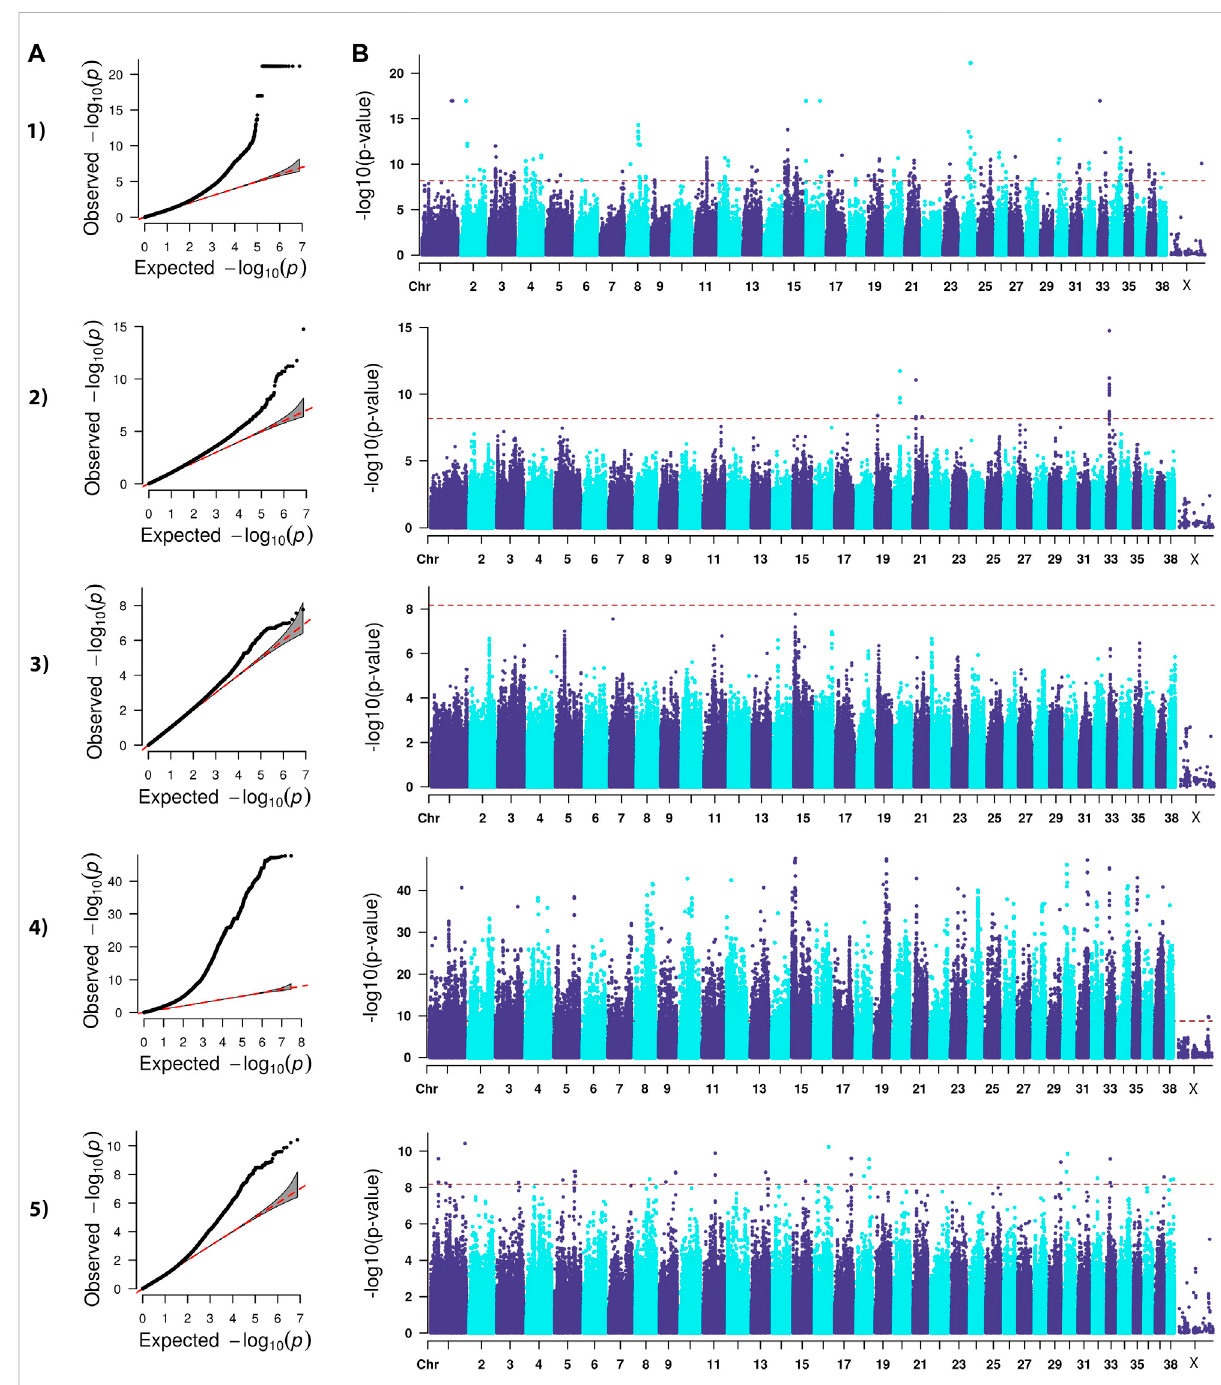
FIGURE 2 QQ (A) and Manhattan (B) plots. Comparison of four models for performing across-breed genome-wide association study using breed phenotypes for elbow dysplasia. 1) Linear mixed model, λ = 0.99, 517 signi fi cant single-nucleotide polymorphisms (SNPs) with the strongest associations on chromosome 1, 2, 8, 15, 16, 24, 30, and 33 ( p < 6.59E-9). 2) Stringent binary case-control model, λ = 1.04, 30 signi fi cant SNPs on chromosome 19, 20, 21, 33( p < 6.68E-9). 3) Lenient binary case-control model, λ = 1.01, no signi fi cant SNPs ( p < 6.64E-9). 4) Haplotype-based model, λ = 1.84, 58,592 signi fi cant SNPs with the strongest associations on chromosomes 1, 8, 10, 12, 13, 15, 19, 21, 23, 24, 30, 31, 33, 34, 35, and 37 ( p < 1.68E-9). 5) Weighted least squares model, λ = 0.96, 90 signi fi cant SNPs on chromosomes 1, 3, 5, 8, 9, 11, 13, 15, 16, 17, 18, 29, 30, 32, 33, 37, and 38 ( p <